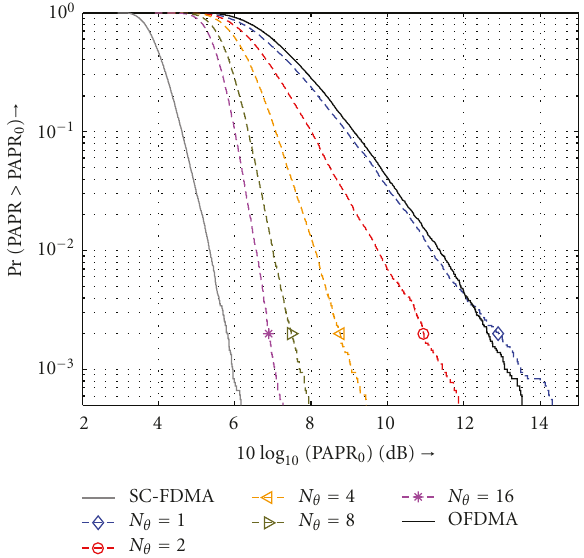
Figure 9: PAPR for SC-FDMA transmission without power allo- cation (solid gray), SC-FDMA transmission with beamforming and power allocation for DFE ( E b /N 0 = 7dB) (dash-dotted), and OFDMA transmission (solid black) for a Pedestrian B channel